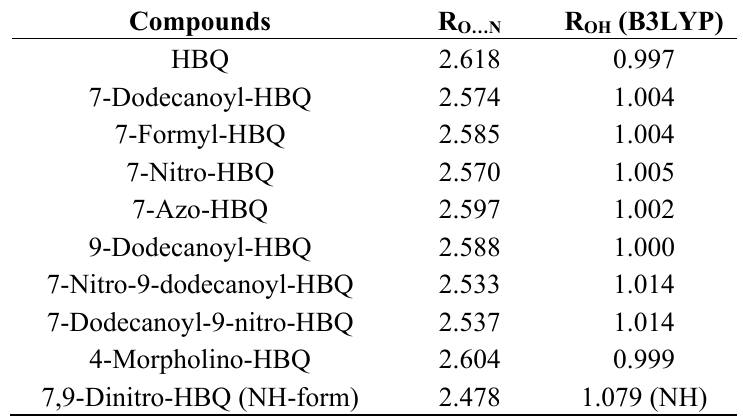
Table 4. Calculated OH bond lengths and O…N distances in